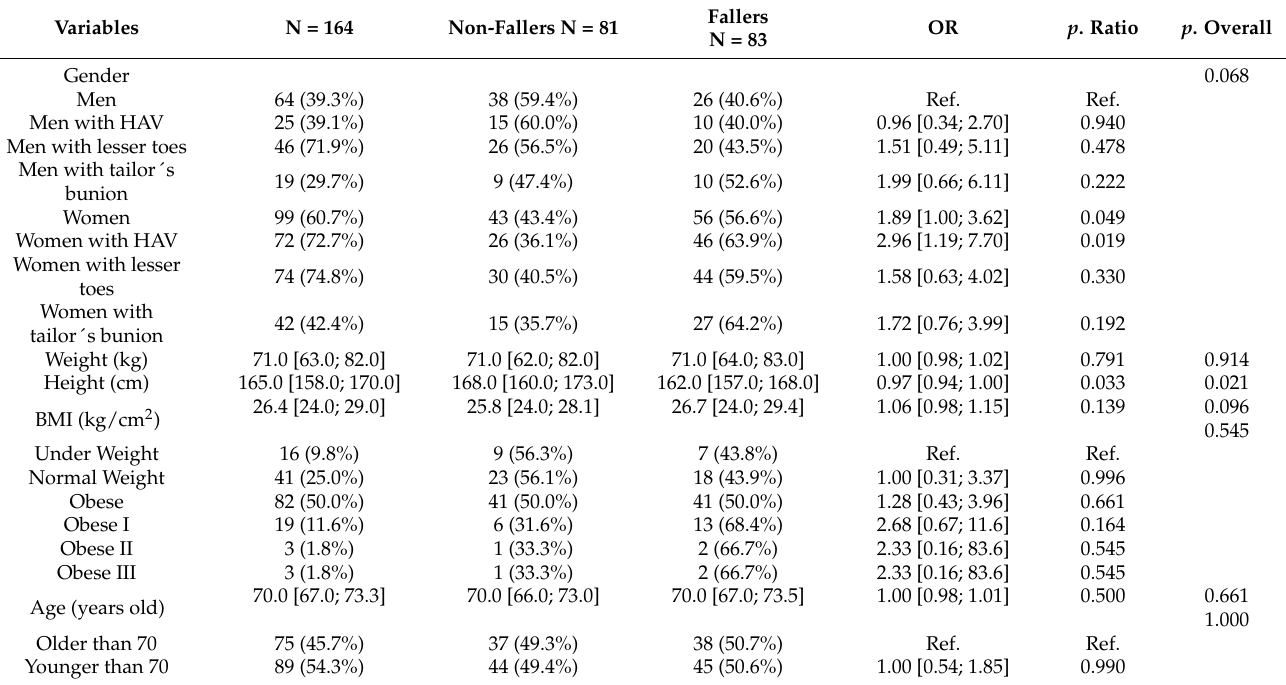
Table 1. Anthropometric description and characteristics of the case and control